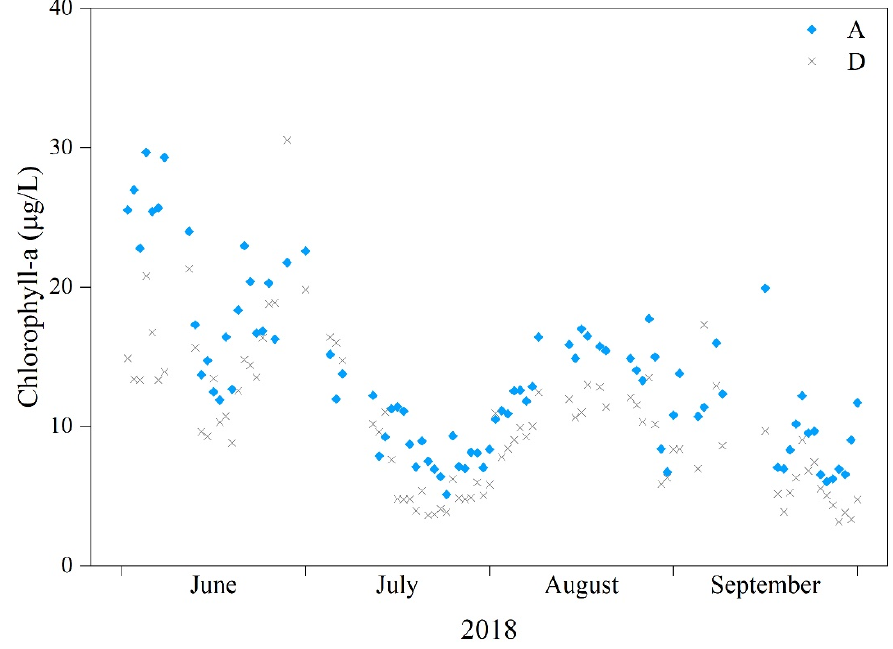
Figure 5. Changes in water temperature with depth in 2018 at (A) the CWCS deployment site and (D) the natural circulation site (200 m away from site A).